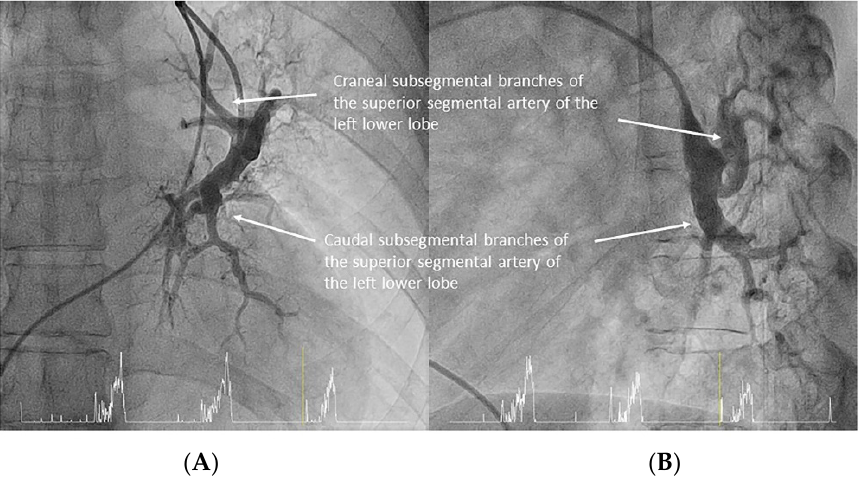
Figure 18. Left lower lobe superior segmental branch (A6): ( A ) anteroposterior and ( B ) lateral views.